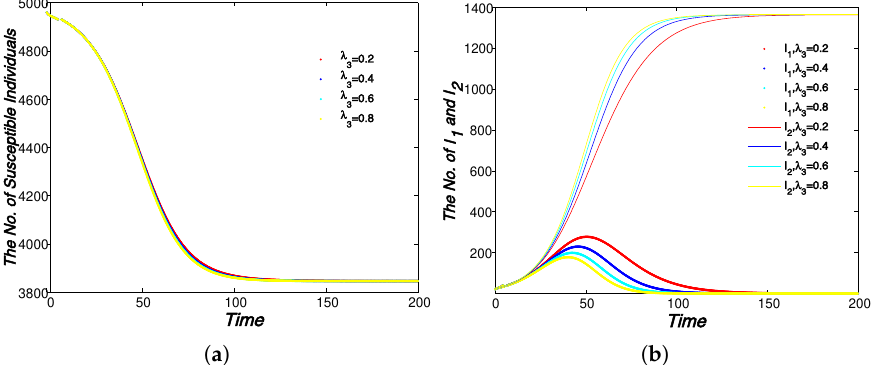
Figure 5. Two pathogens in the super-infection case: 1 < R 01 < R 02 . Here, λ 1 = 0.3, λ 2 = 0.5, γ 1 = 0.4, γ 2 = 0.5. ( a ) Dynamic of S for various values of the parameter λ 3 . ( b ) Dynamics of S , I 1 , I 2 for the boundary equilibrium